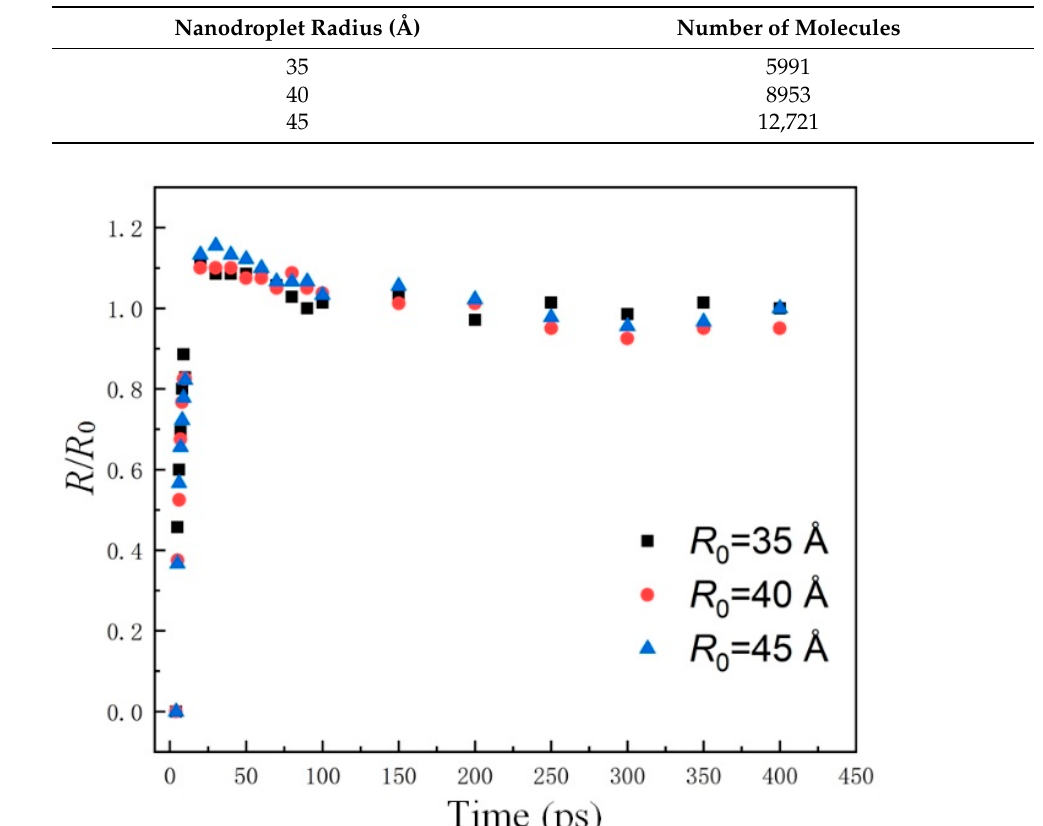
Table 3. Nanodroplets with different radii and the number of water molecules.